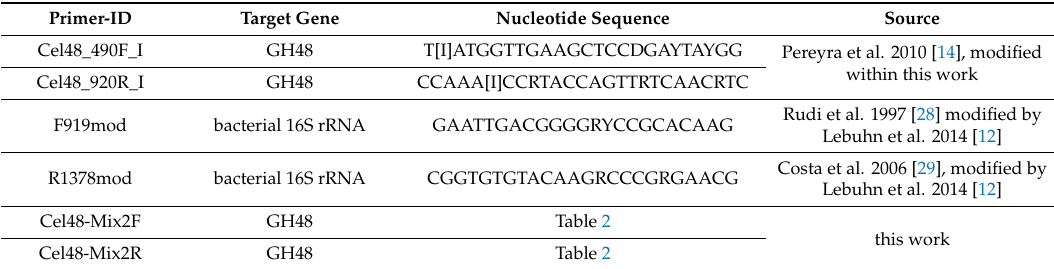
Table 1. Primer used for the amplification of target genes.